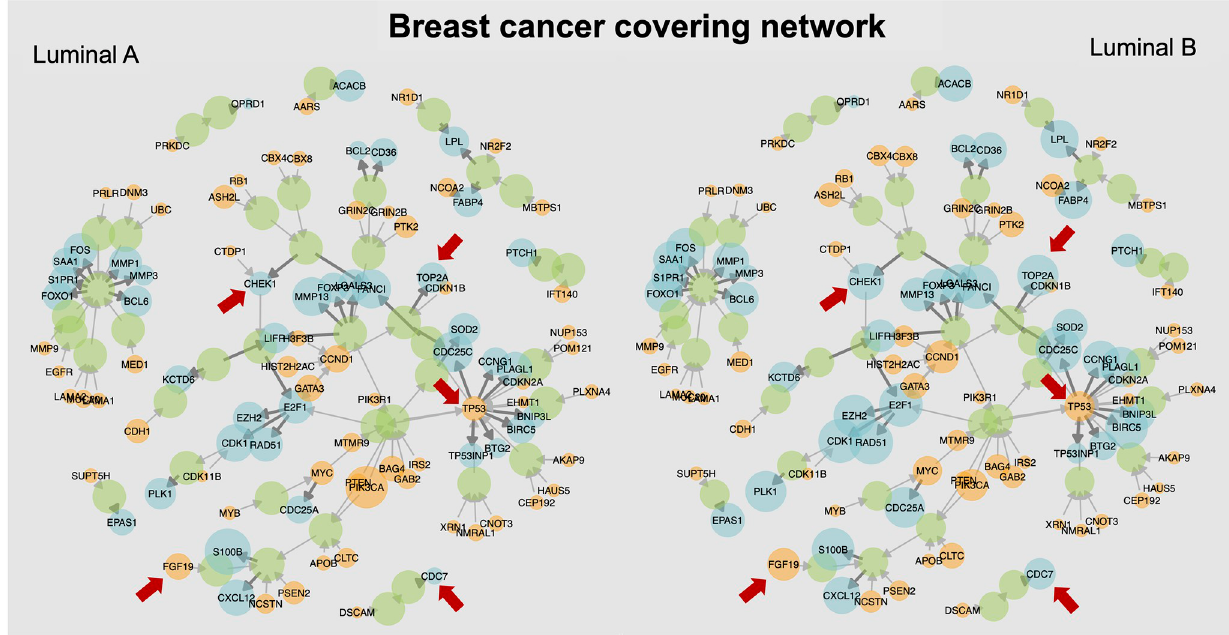
Fig 4. Comparison of one covering network for luminal breast cancer subtypes. The probabilities of DNA aberration (with targets) and RNA aberration (with sources) over the Luminal A and Luminal B populations of breast cancer are depicted by the size of each node in the network, which corresponds to one possible covering. The red arrows indicate some sources and target genes that have noticeable differences in the respective probabilities between the two luminal subtypes ( e.g ., TP53 , CHEK1 , PIK3CA , and TOP2A , also see Table 6).